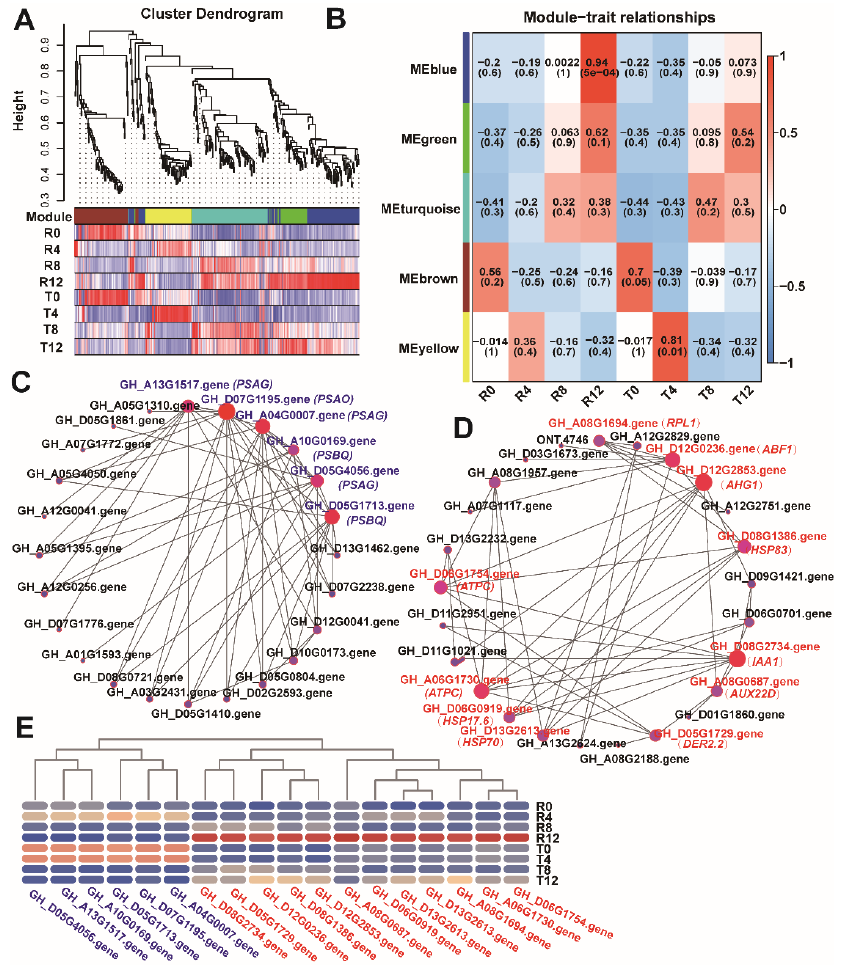
Figure 6. Gene co-expression analysis. ( A ) The cluster dendrogram of all the samples; ( B ) module- trait relationships of the samples; ( C ) network between the genes from the MEyellow module in T4; ( D ) network between the genes from the MEblue module in R12. ( E ) expression profile of the key hub genes.